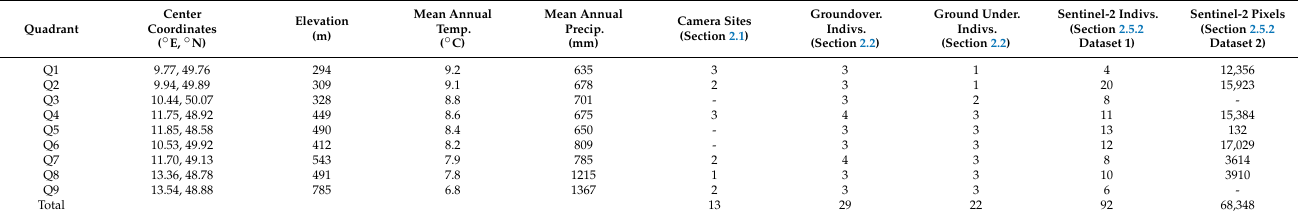
Figure 1. The study quadrants within the federal state of Bavaria, southeast Germany. Table 1. Description of the nine study quadrants (5.8 × 5.8 km), including their center coordinates, elevation, mean annual temperature (1981–2010), mean annual precipitation (1981–2010), as well as the number of samples per method. Note that all samples were taken in two years (2019 and 2020). Camera sites always included one camera facing understory and one camera facing overstory. Abbreviations: temperature (temp.), precipitation (precip.), overstory (over.), understory (under.), individuals (indivs.). “Ground” stands for ground-based visual phenological